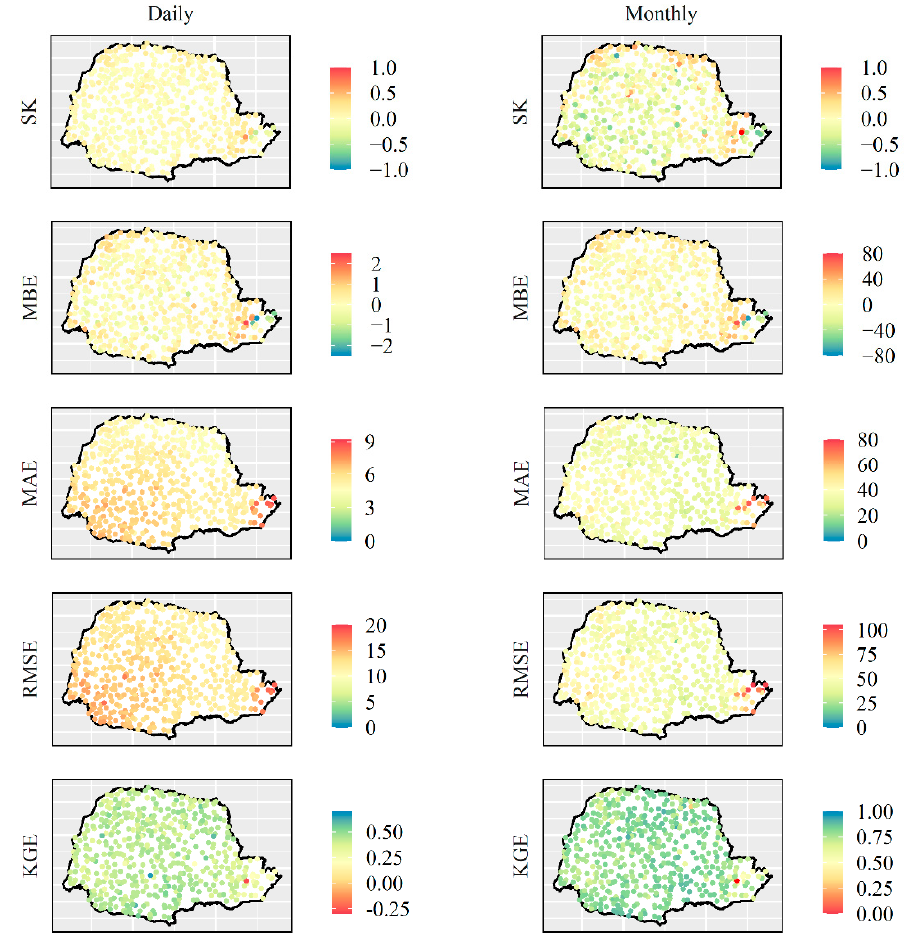
Figure 8. Spatial distribution of performance metrics on a daily and monthly scale.